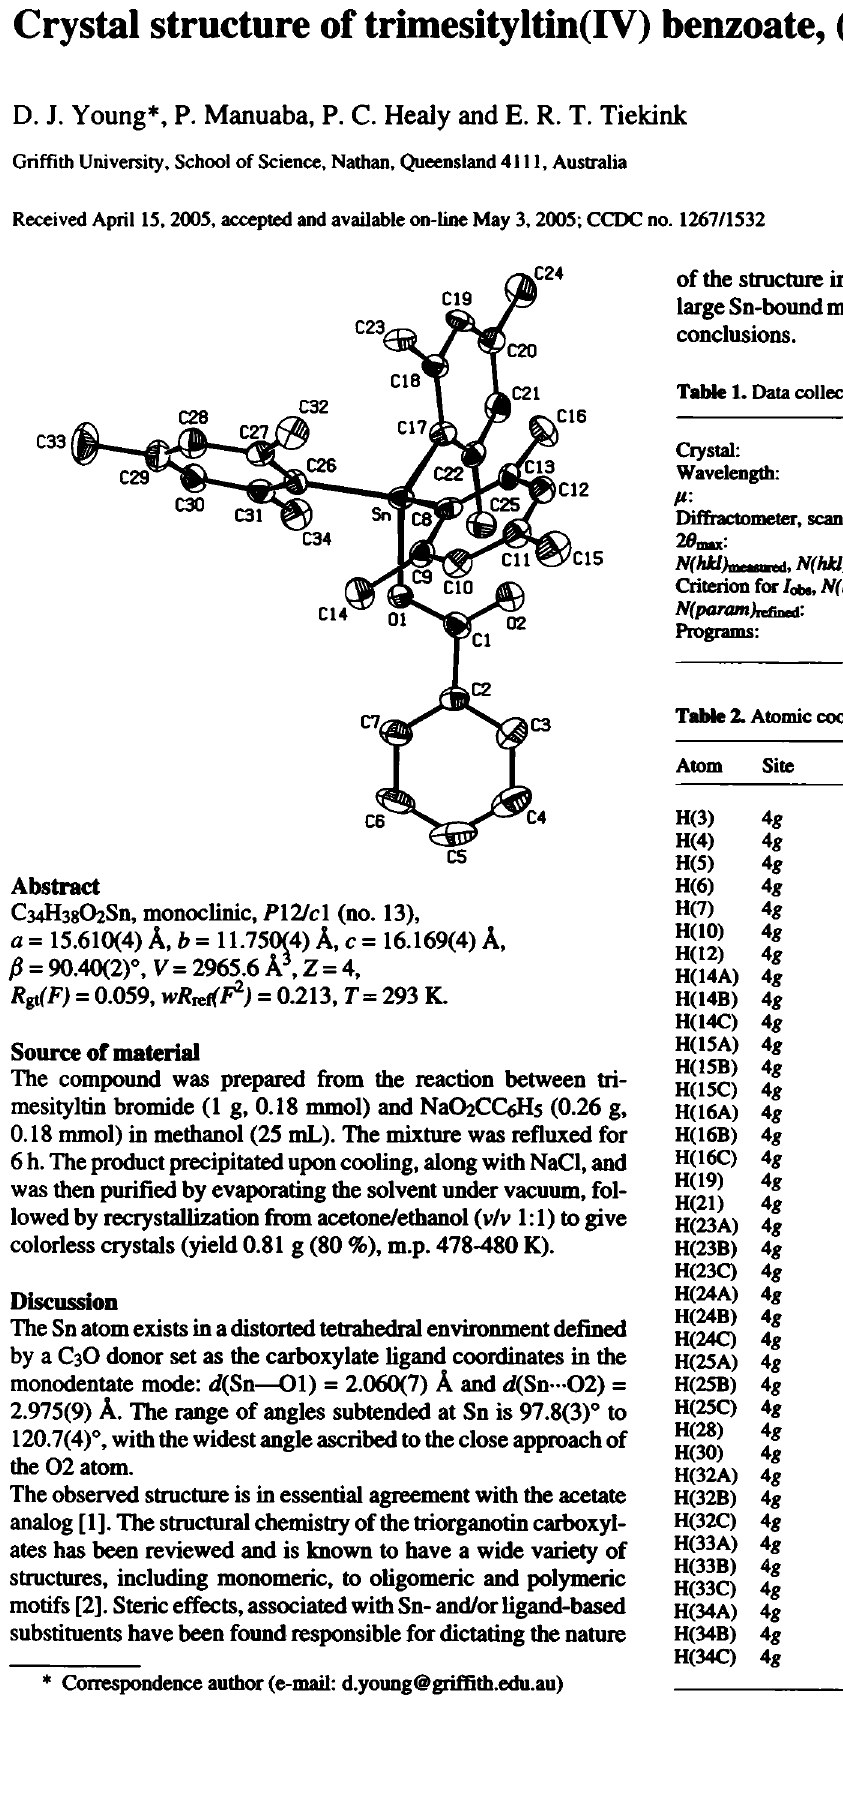
Table 1. Data collection and handling.